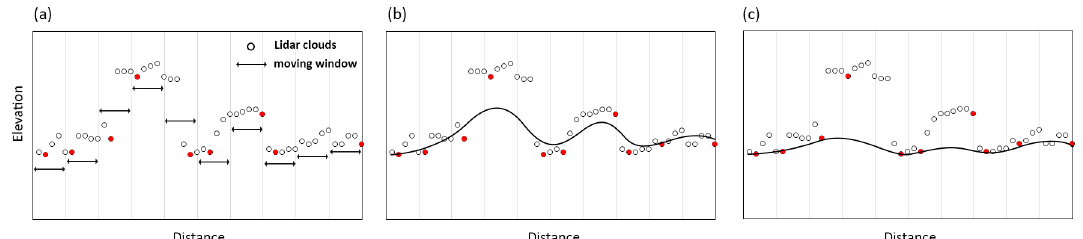
Figure 1. The schematic diagram of surface-based DTM generation methods. ( a ) A lowest point is selected for each cell; ( b ) A coarse surface is produced based on these pre-selected points; ( c ) A refined DTM is generated based on the residue between the coarse surface and the elevation of rest points.